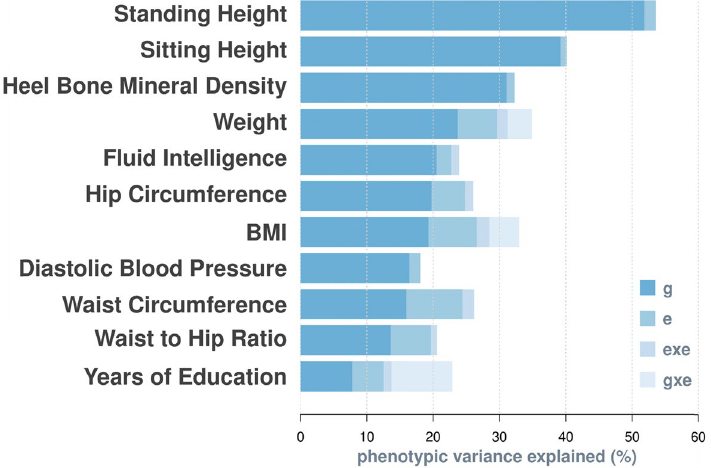
Figure 1. Breakdown of phenotypic variance by the model with the best fit. The best model for each trait is derived from model comparisons shown in Table 1. g : additive genetic effects on phenotypes, e : additive effects of exposomic variables, exe : interaction effects between exposomic variables, gxe : interaction effects between genotypes and exposomic variables. Variance components are expressed as percentage of total phenotypic